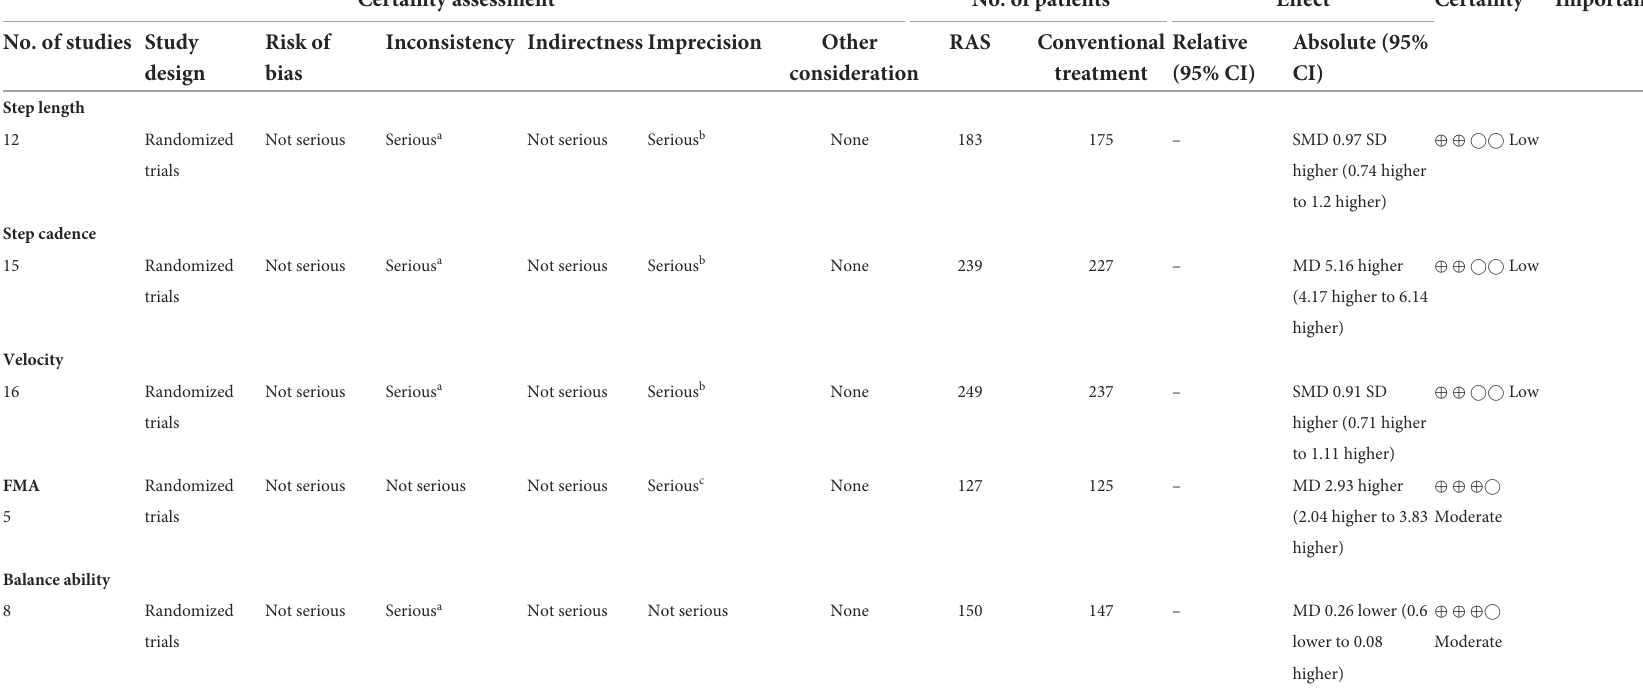
TABLE 4 The quality of the evidence of outcome